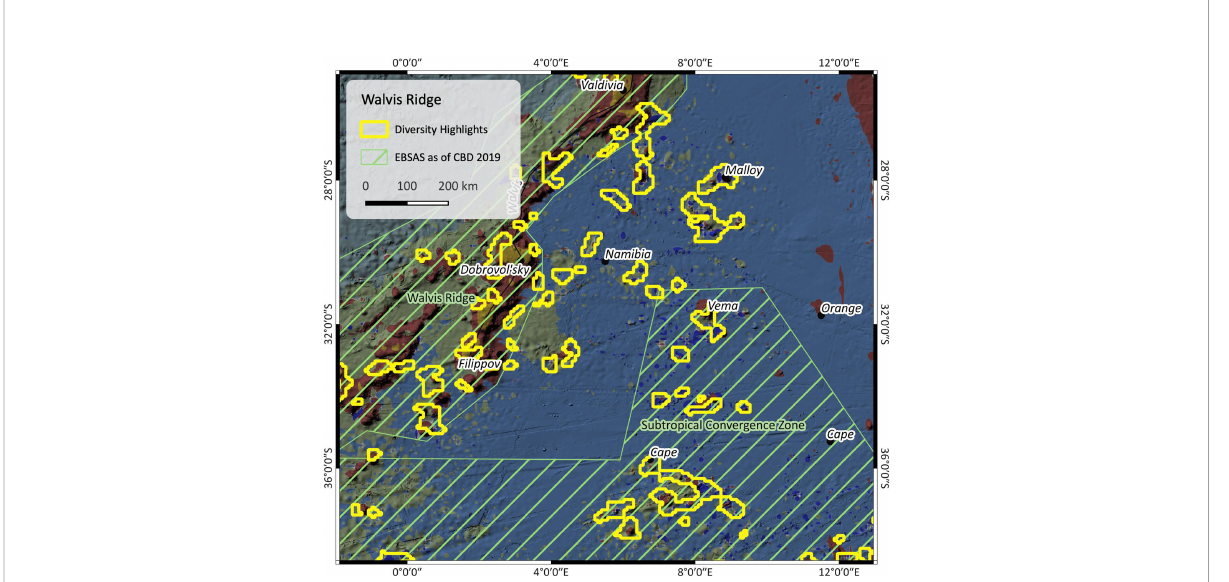
FIGURE 5 Patch richness near Walvis ridge. The outlines are the highlighted regions as found by the patch richness analysis. The map also shows EBSAs (green stripes) as of CBD 2019. For SBA color legend, please refer to Figure